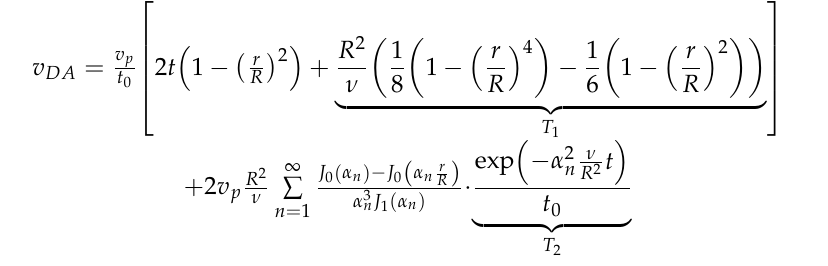
time when piston motion stops.